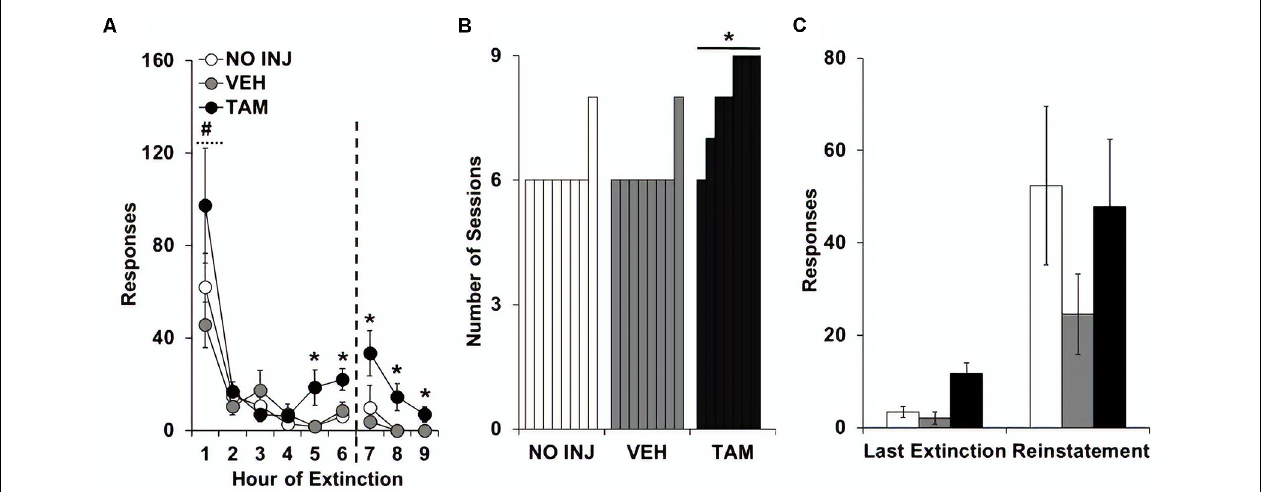
FIGURE 3 | Tamoxifen impaired extinction learning. (A) Mean ( ± SEM) active-lever responses made during the nine extinction sessions for the no-injection (NO INJ; n = 8), vehicle (VEH; n = 8) and tamoxifen (TAM; n = 7) groups. The dotted line indicates that additional extinction sessions were run for rats that did not meet the extinction criterion within the first six sessions ( ≤ 15 responses; one of the eight rats in the NO INJ and VEH groups and six of the seven rats in the TAM group). ∗ Significant difference between the VEH and TAM groups (session 5, P = 0.017; session 6, P = 0.029; session 7, P = 0.035; session 8, P = 0.007; session 9, P = 0.02); # Significant effect of session (1 vs. 2–9, P < 0.0001). (B) Number of sessions required to extinguish responding ( ≤ 15 responses). ∗ Unequal distribution across groups. (C) Mean ( ± SEM) active-lever responses made during the last extinction session and reinstatement test session.